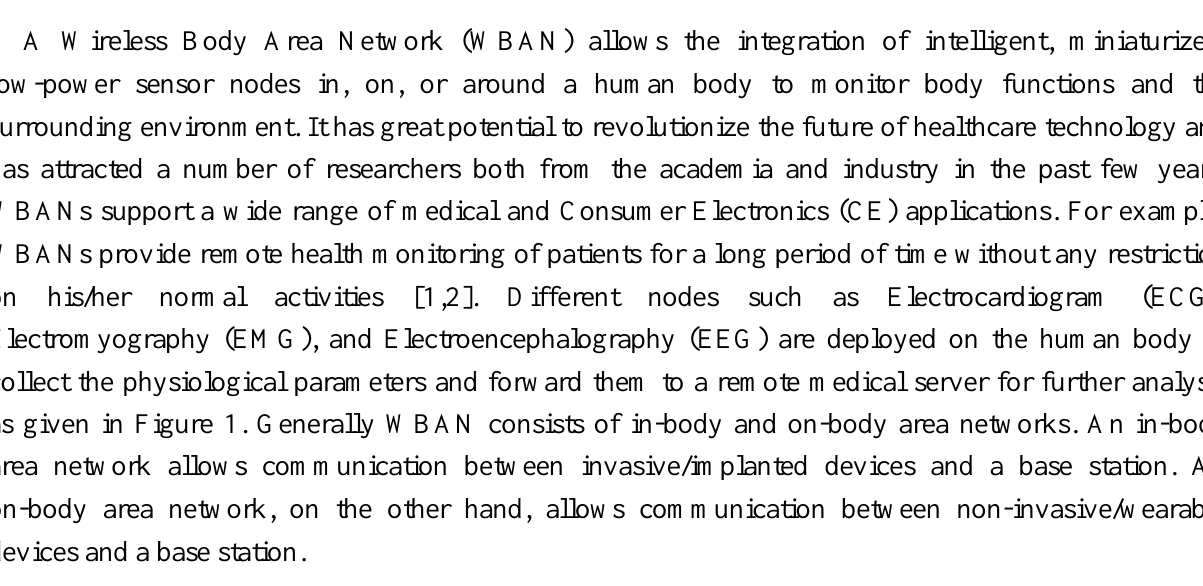
Figure 1. WBAN architecture for medical